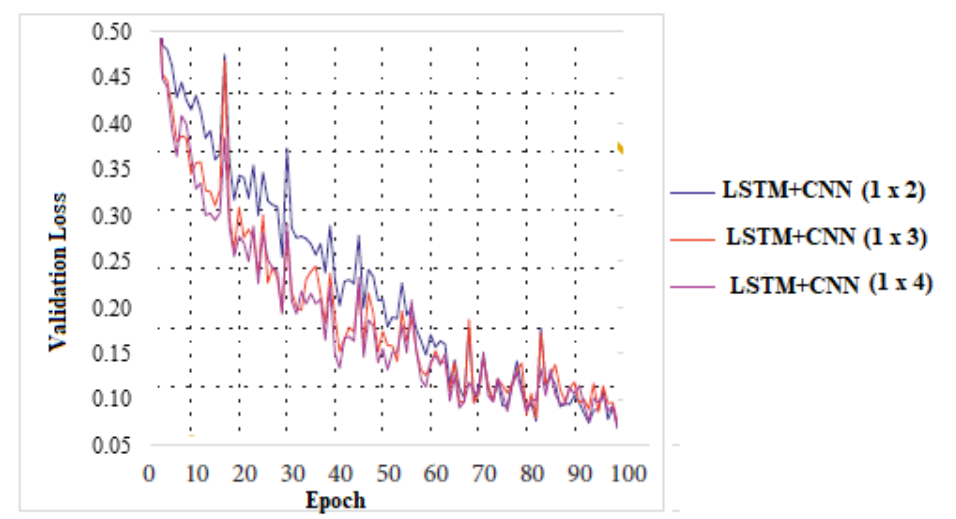
Figure 17. Study of the parameter ( γ ) of validation loss.